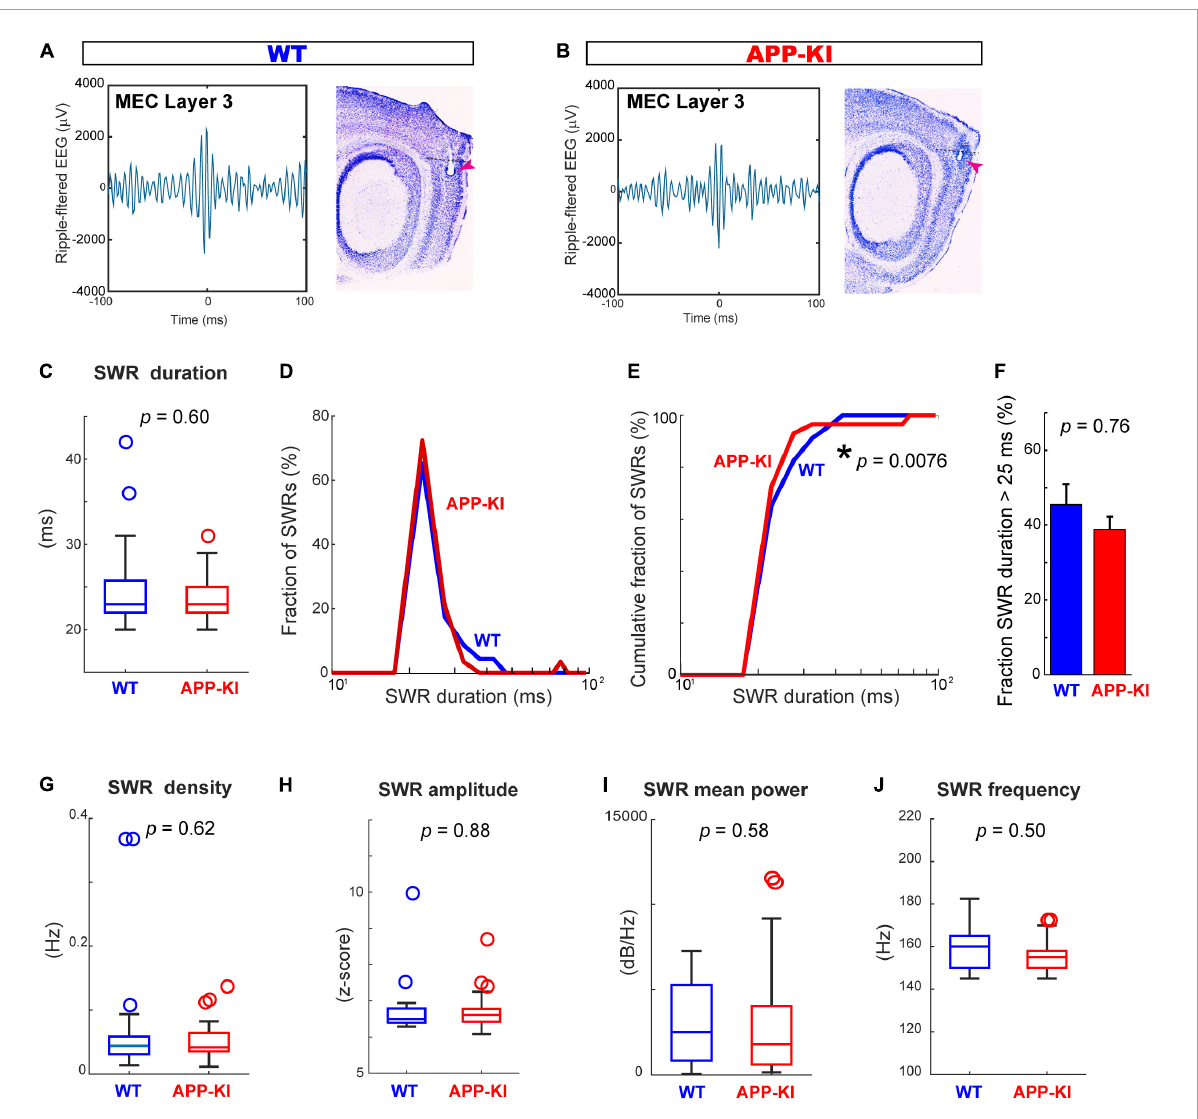
FIGURE4 SWR characteristics in the MEC were comparable between APP-KI mice and WT mice. (A,B) Example SWR traces recorded from the MEC in WT (A) and APP-KI mice (B) . (C) SWR duration in MEC. p = 0.60, Wilcoxon rank-sum test. (D) Fraction of MEC SWRs plotted as a function of SWR duration. (E) Cumulative fraction of MEC SWRs as a function of SWR duration; p = 0.0076, Kolmogorov-Smirnov test. (F) Fraction of MEC SWRs with duration of > 25 ms; p = 0.76, Wilcoxon rank-sum test. (G–J) SWR properties in CA1. SWR density (G) , SWR amplitude (H) , SWR mean power (I) and SWR Frequency peak (J) . P -values are from Wilcoxon rank-sum test. For all data in (C–J) , n = 23 and n = 29 CA1 recordings in WT and APP-KI mice, respectively. * p <